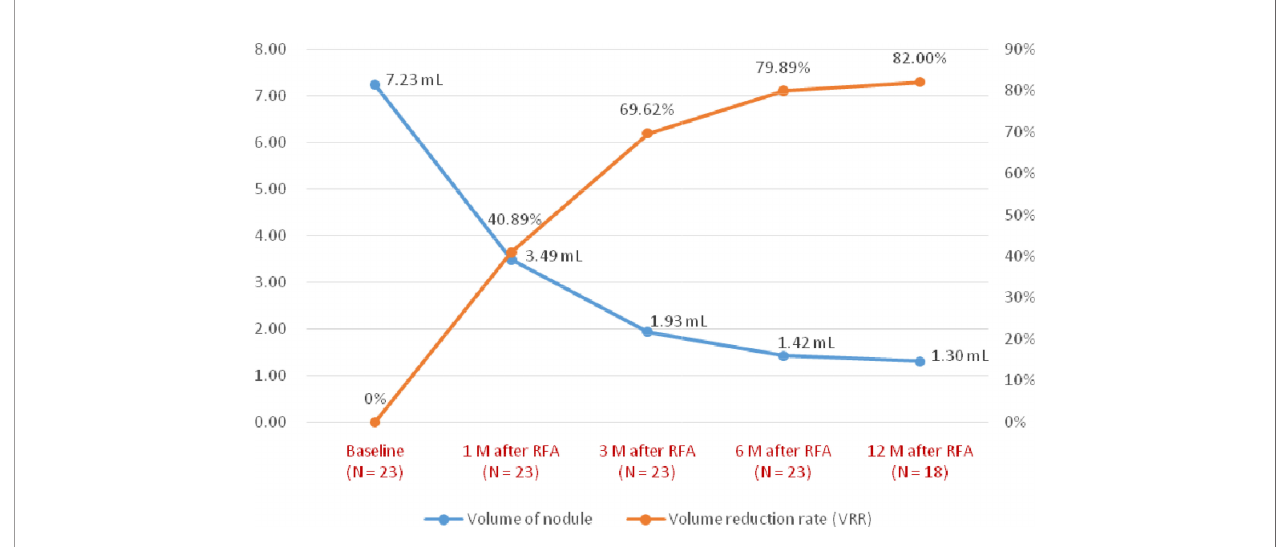
FIGURE 4 | The median changes in the volume of nodules and volume reduction rate during the follow-up.